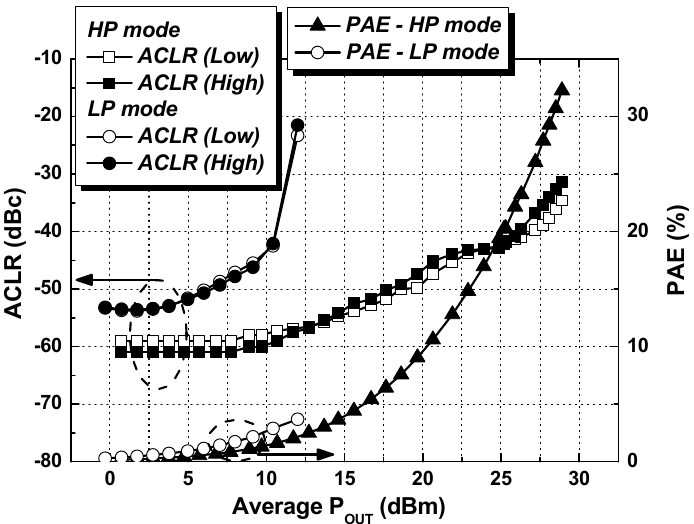
Figure 15. Measured ACLR and PAE for the 64-QAM OFDM signal with a bandwidth of 10 MHz at